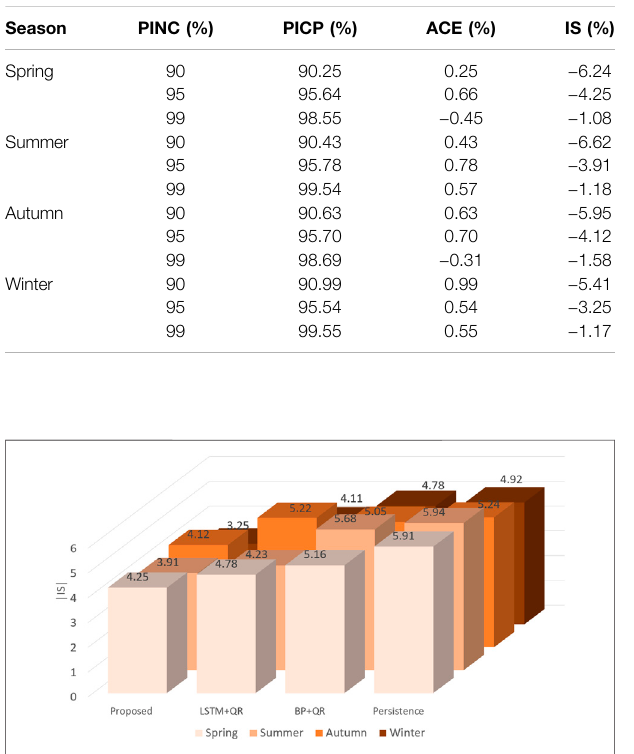
TABLE 2 | Probabilistic forecasting error in different